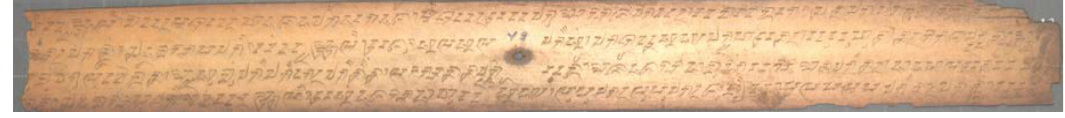
Figure 3. Sundanese palm leaf manuscript.